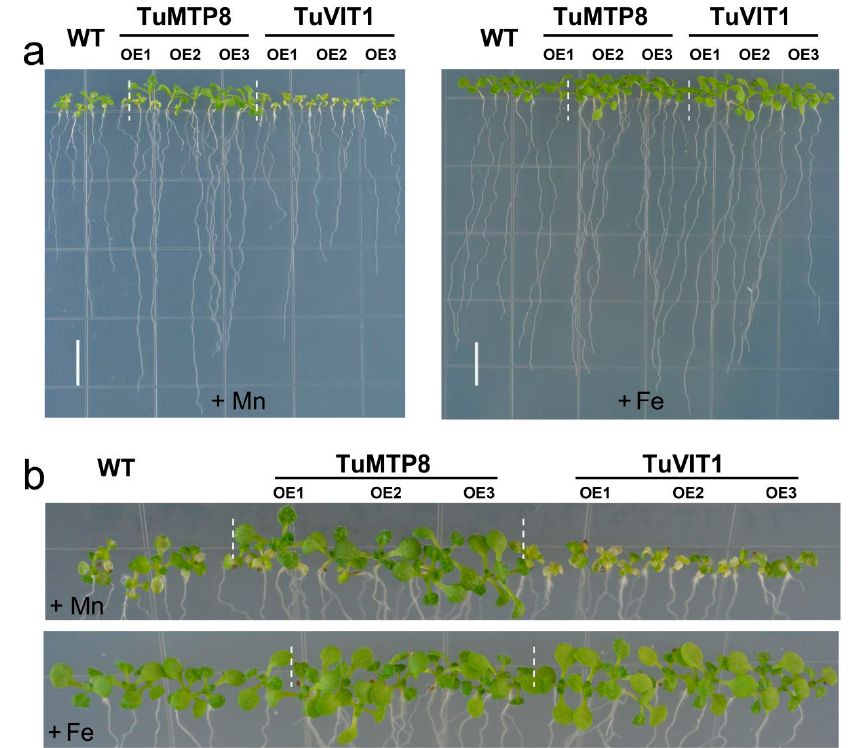
Figure 6. Comparison of growth between over-expressing TuMTP8 and over-expressing TuVIT1 Arabidopsis . ( a ) WT, TuMTP8 -OE and TuVIT1 -OE transgenic Arabidopsis seeds were grown on vertical ½ MS solid medium supplemented with 1 mM MnSO 4 and 100 μ M FeSO 4 , respectively. Seedlings were grown for 14 days. Bars = 1 cm. ( b ) Enlarged images of the shoots in ( a ). Three biological repeats were carried out with similar results. Four to six plantlets per genotype from one plate were measured for each repeat.